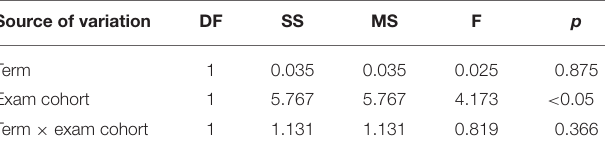
TABLE 2 | Influencing factors on separate grades in the oral exam in animal